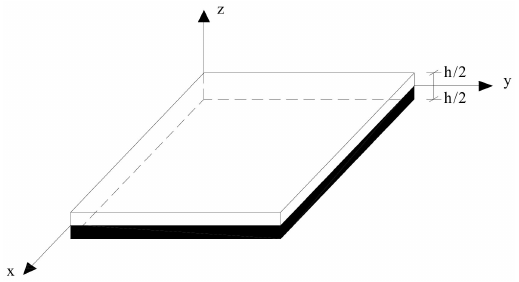
Figure 1. Material properties of FGM across the plate